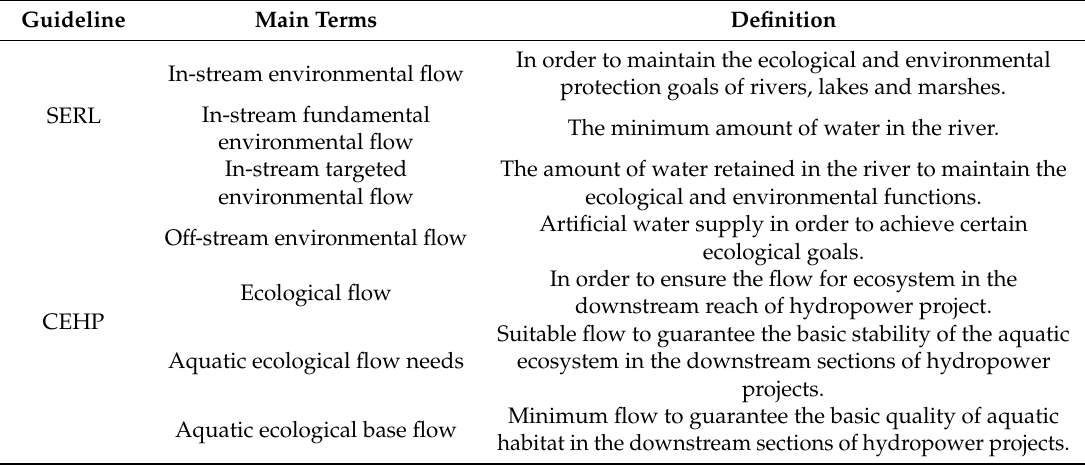
Table 4. Comparison of key terms definitions of the two standards for development of water use projects.